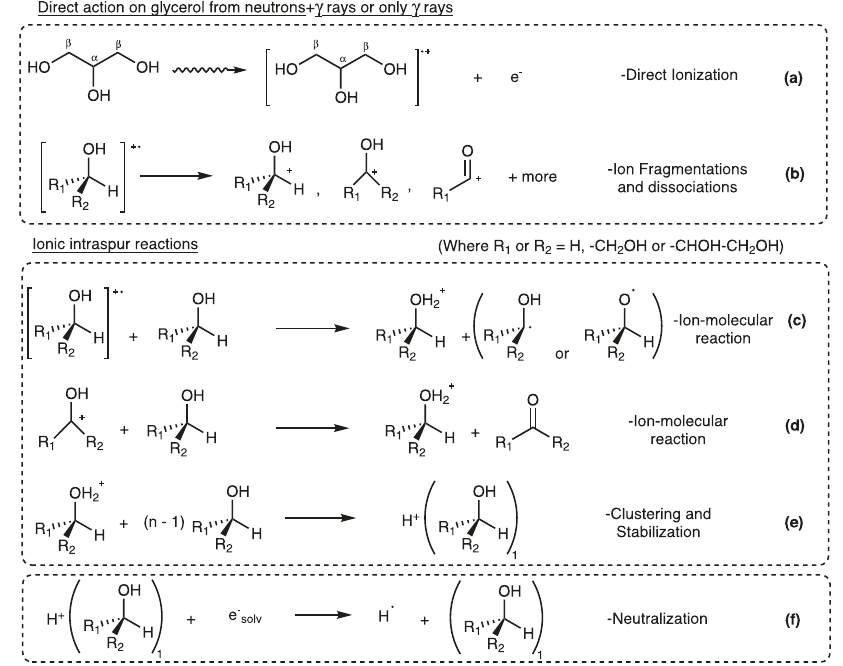
Fig. 3 Proposed selected initial mechanisms from “ direct action ” upon pure neat glycerol. a Direct ionization. b Ion fragmentations resulting in most C – C or C – O scissions. c , d Ion dissociation reactions forming acidic glycerol cations and with either radicals or carbonyl species. e Clustering and stabilization of acidic glycerol. f Neutralization of acidic glycerol via solvated electrons. Since H-dissociation could occur at any hydroxyl carbon of glycerol, R 1 and R 2 = – CH 2 OH for α -carbon or – H and – CHOH – CH 2 OH for β -carbon species,